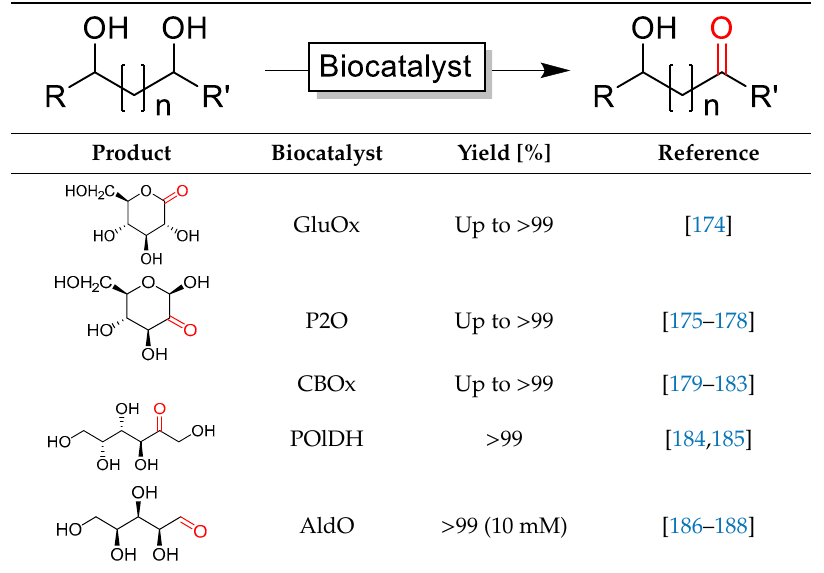
Table 4. Selection of biocatalytic oxidations of secondary alcohols.